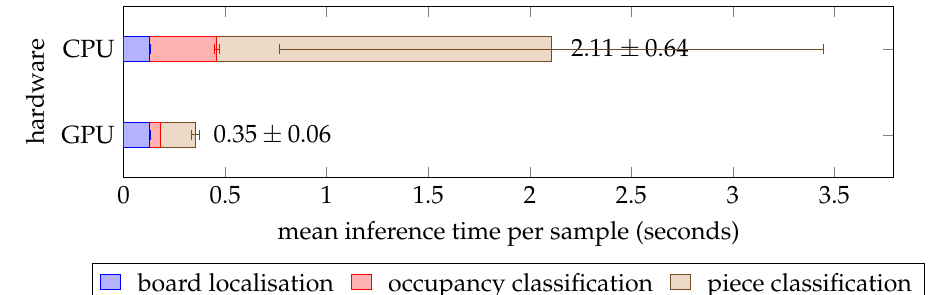
Figure 12. Inference time benchmarks of the chess recognition pipeline on the test set, averaged per sample. The error bars indicate the standard deviation. All benchmarks were carried out on the same machine, although the data for the trial labelled CPU was gathered without GPU